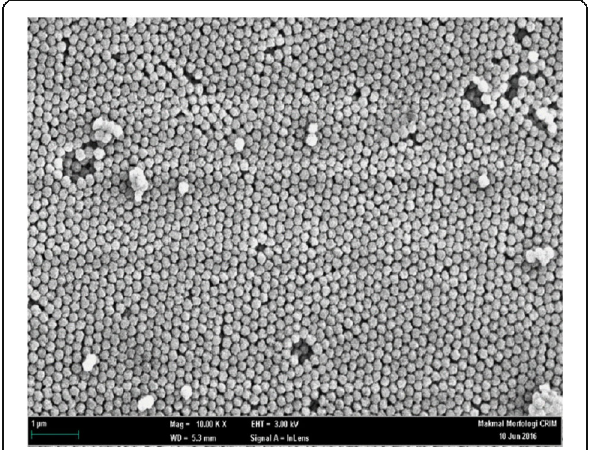
Fig. 2 SEM micrograph of the as-synthesised PSA latex spheres at 10,000 magnifications